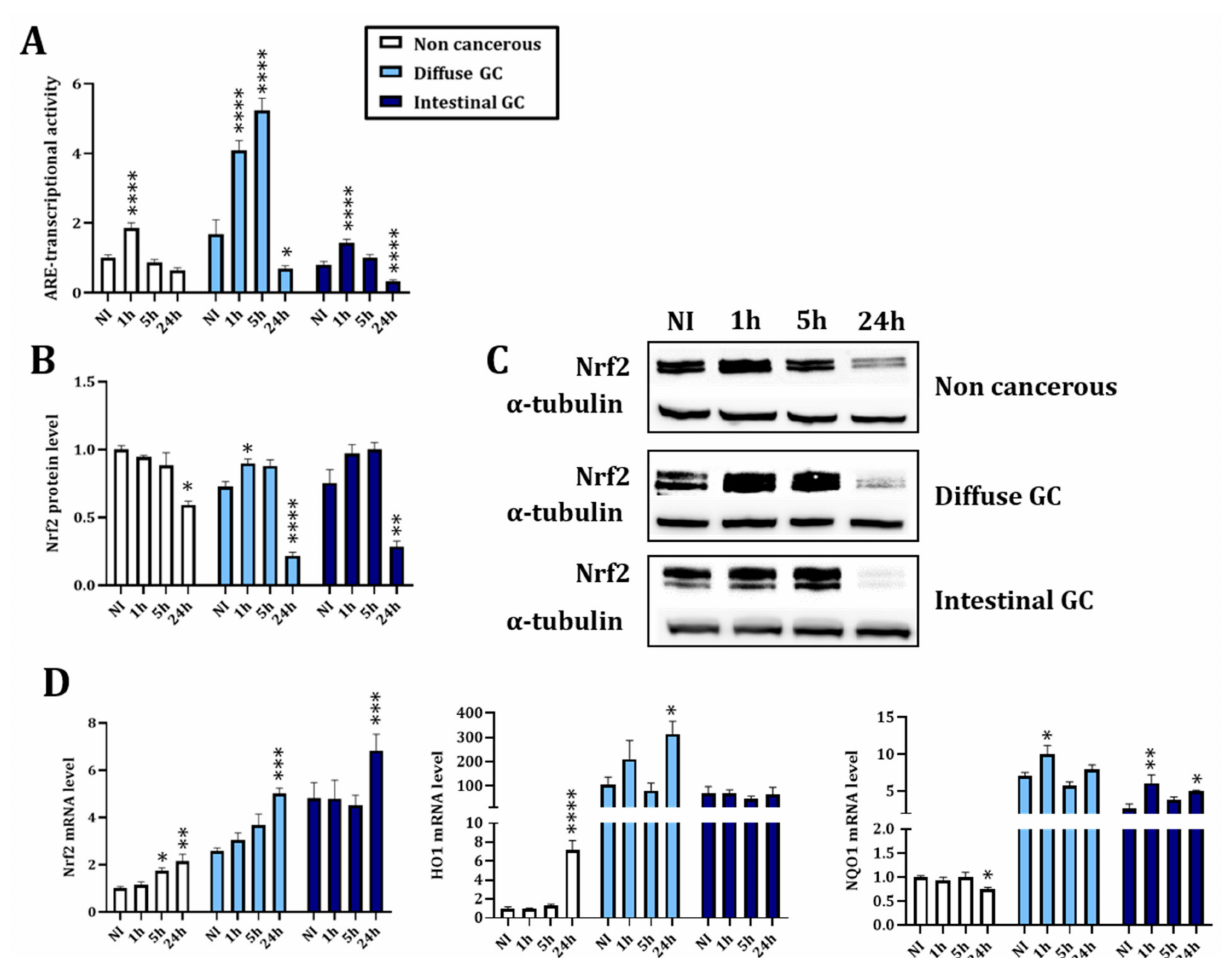
Figure 1. Kinetic infection with H. pylori modulates Nrf2expression and activity. ( A ) Evaluation of the Nrf2 activity by assessing the Antioxidant Responsive Element (ARE) transcriptional activity by a biochemiluminescent assay. ( B ) Evaluation of Nrf2 expression by Western blotting. The uncropped blots and molecular weight markers are shown in Supplementary Figure S7. ( C ) Representative images of the Nrf2 Western blotting. ( D ) Evaluation of the mRNA level of Nrf2 and two of its common target genes by RT-qPCR. NI: uninfected cells. One hour, 5 h and 24 h are the timepoints of the infection kinetics. Mean ± SEM of 3–5 independent experiments. Statistics were performed per cell line with one-way ANOVA followed by a Tukey’s multiple comparisons test. All p -value < 0.05 were considered significant. *: significant difference compared to NI. * < 0.05, ** < 0.01, *** < 0.001 and **** <